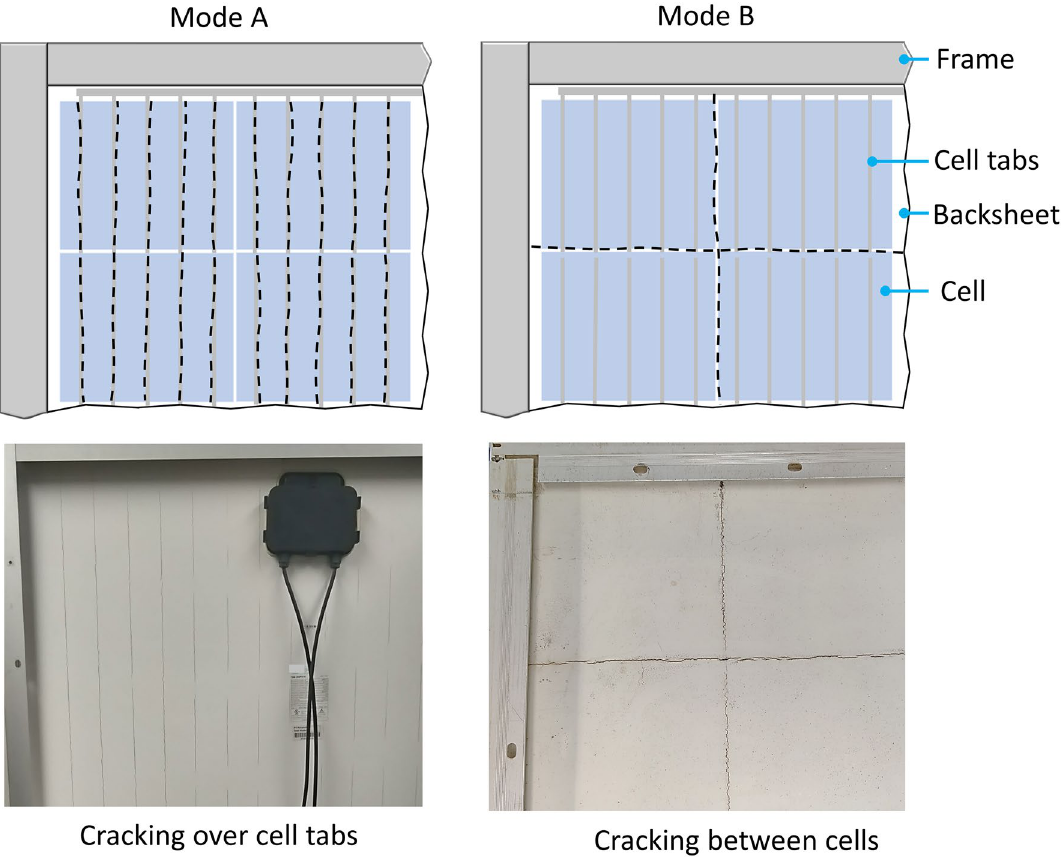
Figure 1. Schematic of the observed cracking modes in the backsheet with Mode A; cracking over cell ribbons and Mode B; cracking in the area between cells. Black dashed lines indicate crack location and orientation. Blue squares indicate relative cell